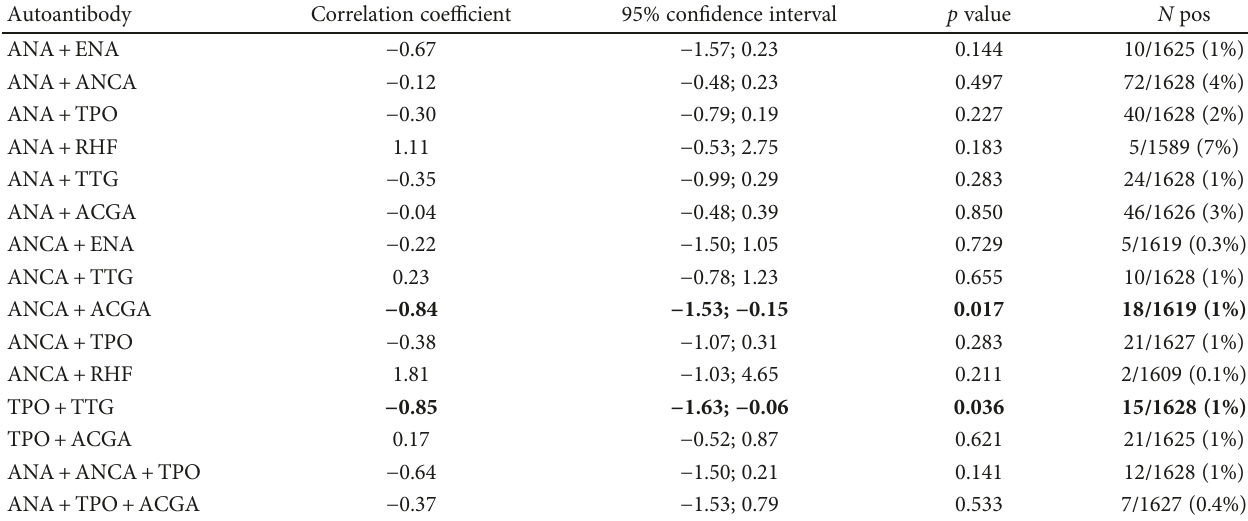
Table 9: Association between quantitative ultrasound index (QUS index) and the coexpression of more than one autoantibody (for available